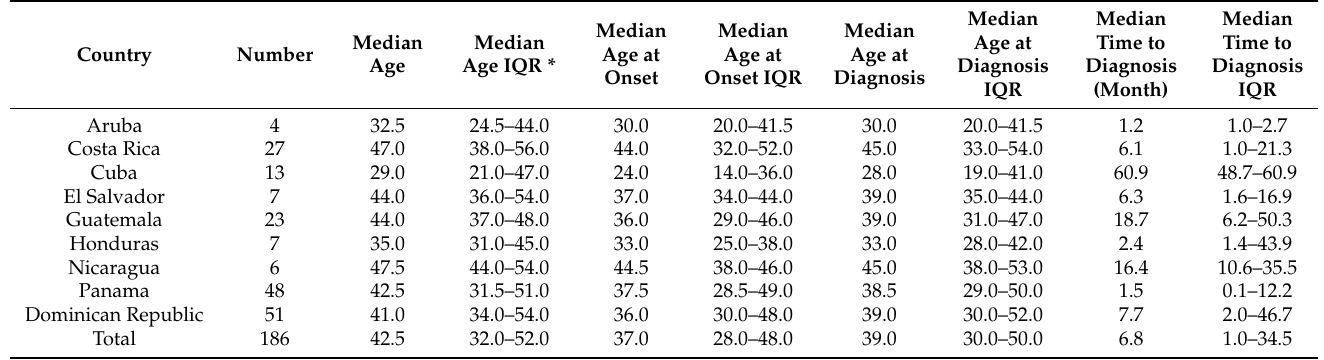
Table 2. Age, median age of onset, time to diagnosis and interquartile range.